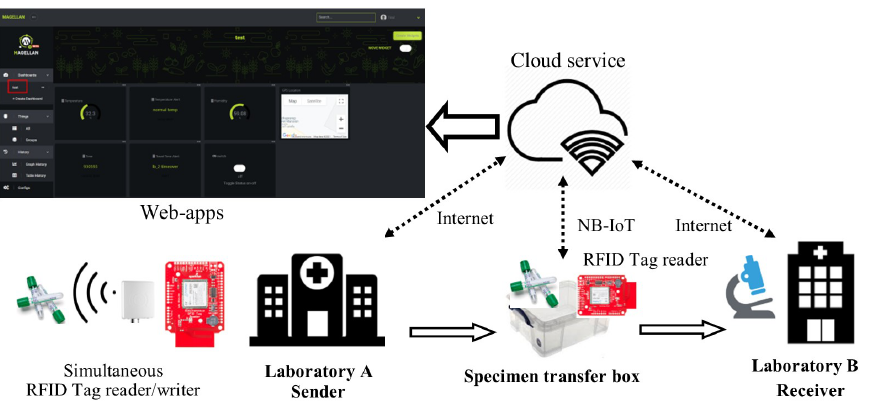
Figure 2. The overall proposed method for specimen transportation. Only the environment and GPS location of the box are uploaded to cloud via the NB-IoT